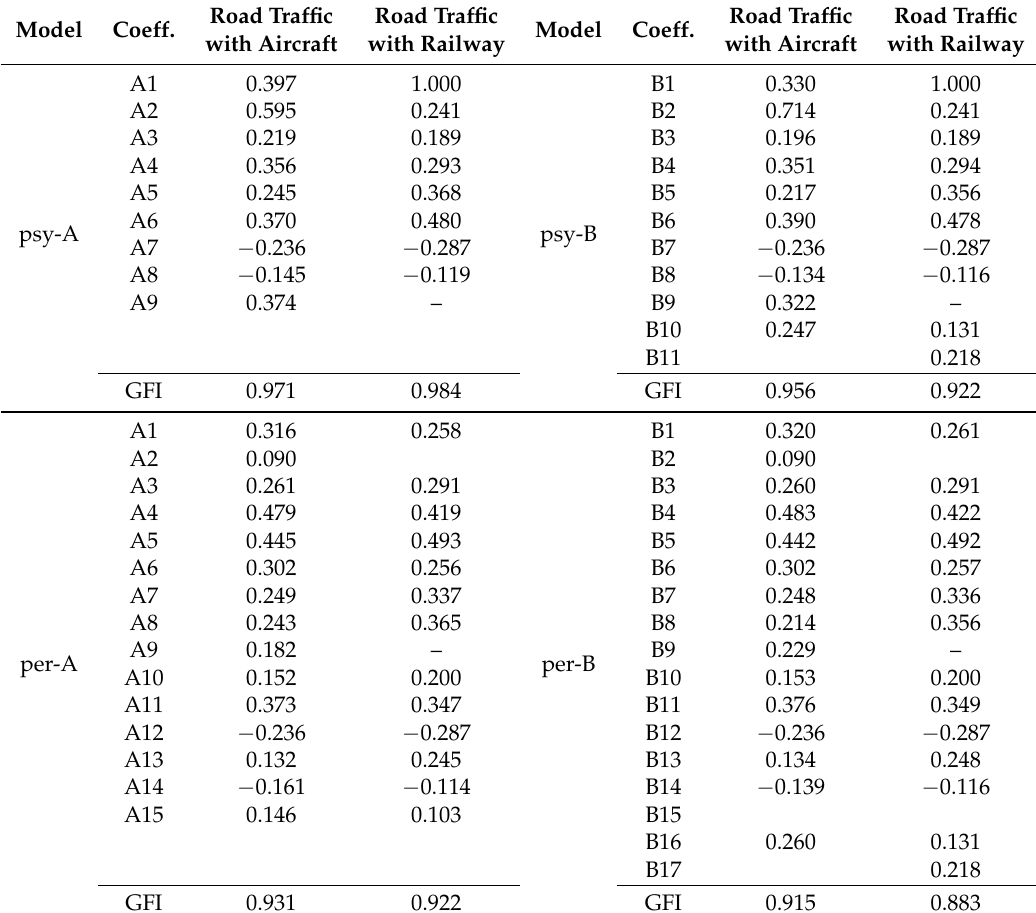
Table 9. Standardized coefficients for both psychophysical and perceptual models of total annoyance due to combined noises, without and with Visibility of noise